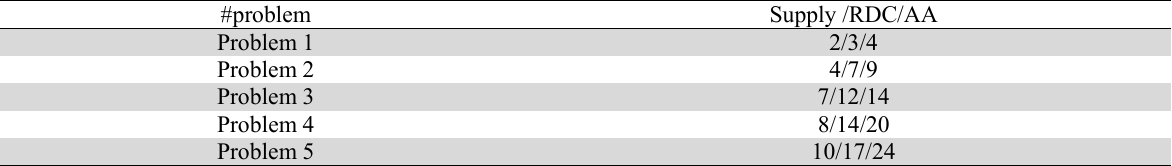
Characteristics of the randomly generated test